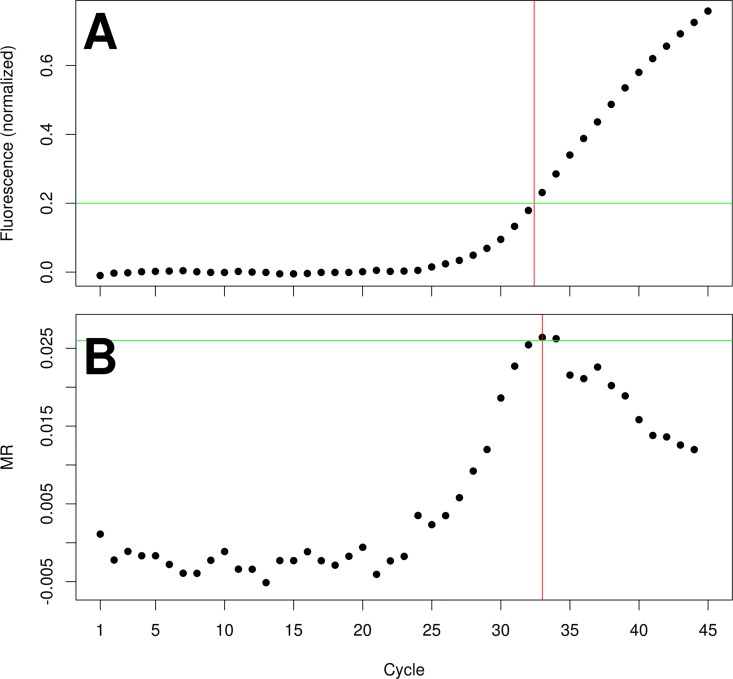
Representative amplification profile of the MR false positive results.Fluorescence amplification profile of the single reaction identified as false positive by the MR method in comparison to the consensus classification. A: the normalized fluorescence profiles indicates a proper amplification but the signal is weak, being only about three times the cut-off level of 0.2 fluorescence units (horizontal line). The Cq of this reaction (32.42 cycles) is reported (vertical line). B: the MR response for this reaction shows a good profile but the MR value (horizontal line) is below the empirical cut-off obtained using the training dataset, therefore the reaction was identified as negative. The FCN value (33.82 cycles) is depicted (vertical line).